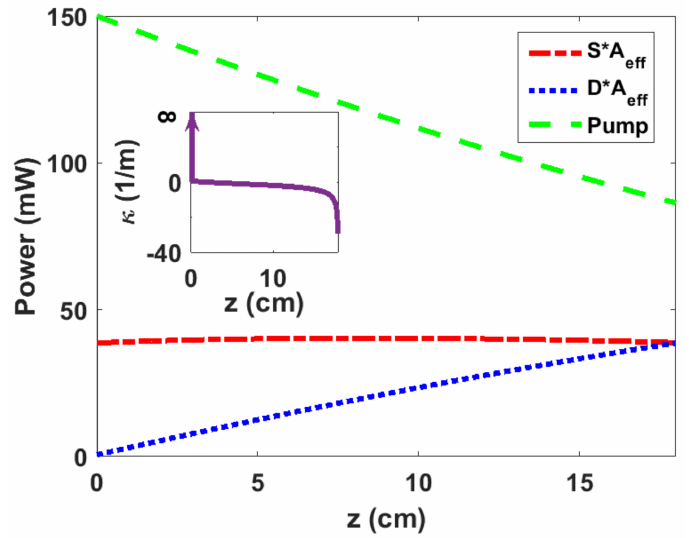
Figure 3. Distribution of SA eff and DA eff and P p as a function of EDF-DFB length for a pump power of 150 mW and a loss of 0.3 dB/m, resulting in S = D at 18 cm. Note, the intra-cavity power distribution (in red) is nearly flat. The inset shows the coupling coefficient distribution over the 18-cm-long EDF-DFB. Coupling coefficient is very large at z = 0 due to the full unidirectionality assumption. The zero crossing, i.e., PPS occurs at 1.9